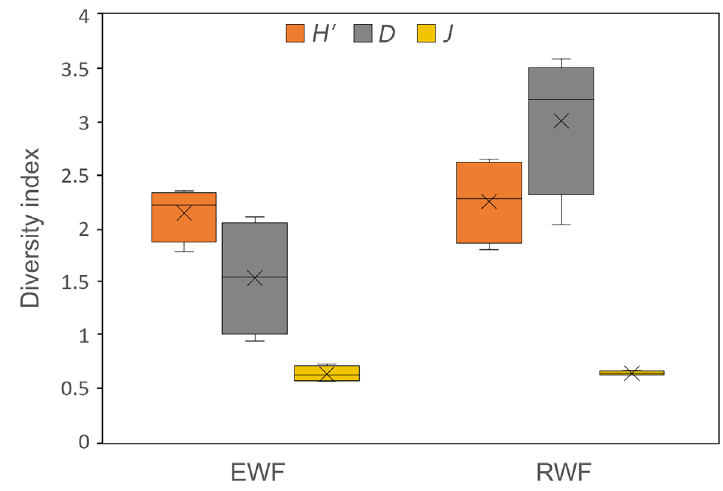
Figure 5. Zooplankton diversity index. Abbreviations used in the diagram: H ′, Shannon –Wiener diversity index; D , Margalef richness index; J , Pielou evenness index.